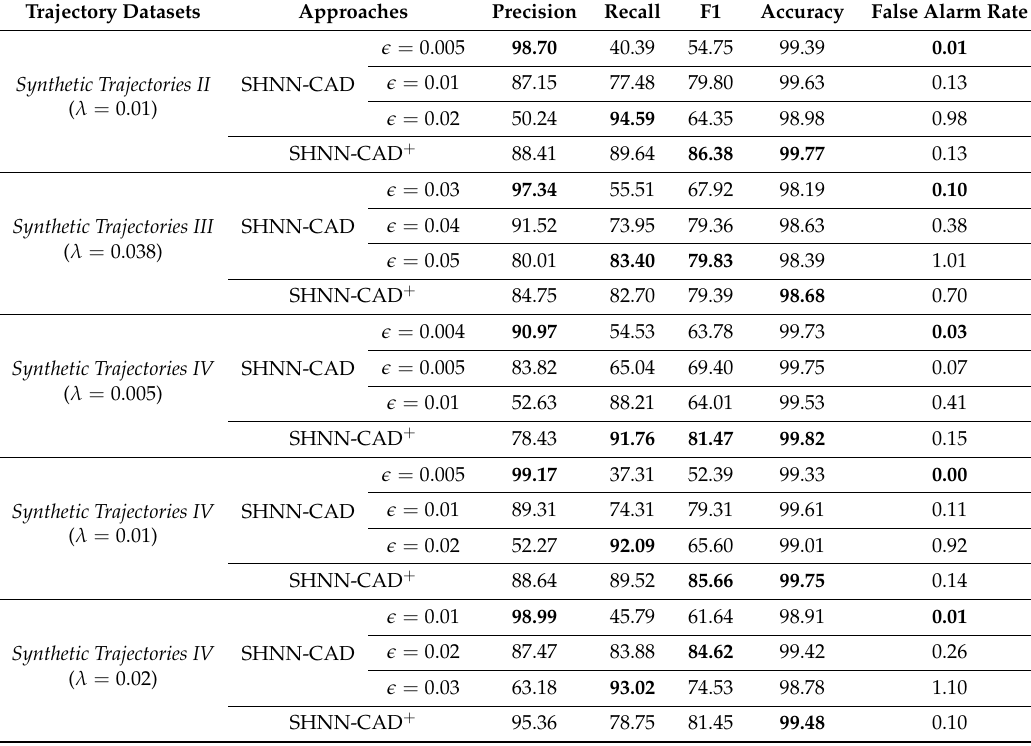
Table 4. Five Performance Measures (%) of Online Learning and Anomaly Detection on Different Trajectory Datasets. Note that we found a mistake in Table 3 of [10] where the given result of Sequential Hausdorff Nearest-Neighbor Conformal Anomaly Detector (SHNN-CAD) is different with the description of Algorithm 2 in [10]. The F1 result, 53.52, 74.61, and 61.68, of SHNN-CAD with (cid:101) = 0.005,0.01, and 0.02, respectively, is given under the condition that if p -value ≤ (cid:101) , the testing trajectory is classified as abnormal. In the table below, we follow the rule in Algorithm 2 [10] for SHNN-CAD. The best performance of each collection of datasets is in